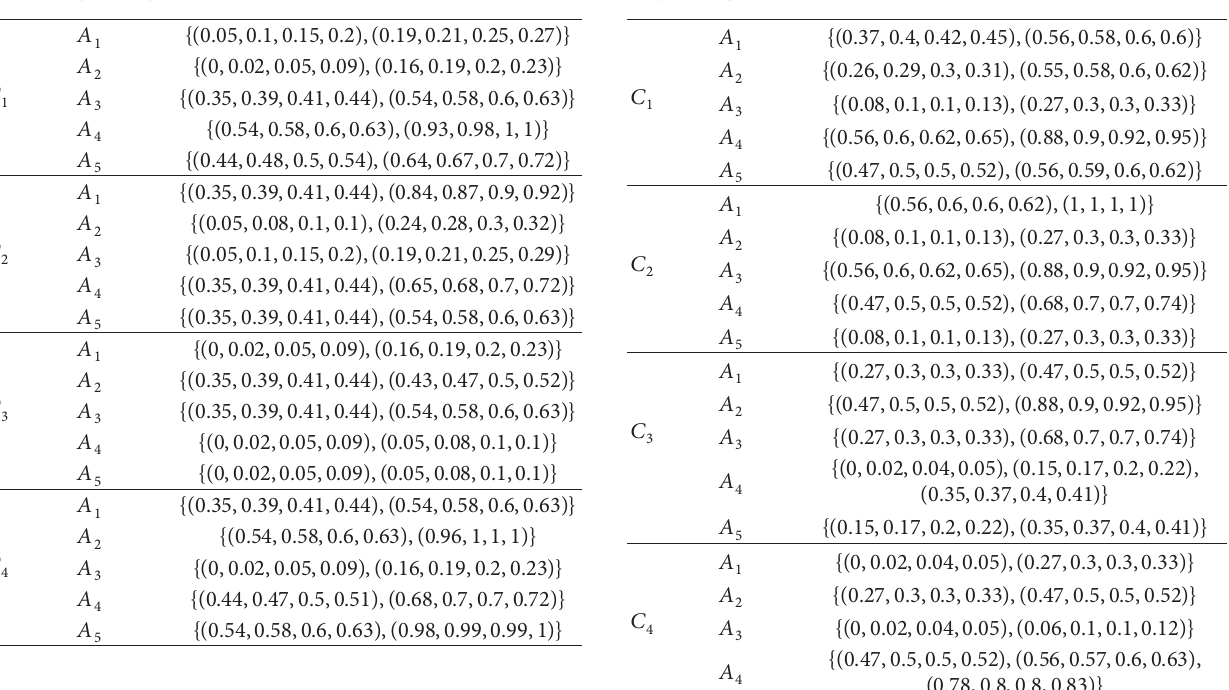
̃𝑋 2 ) with respect to decision makers 4, 5,